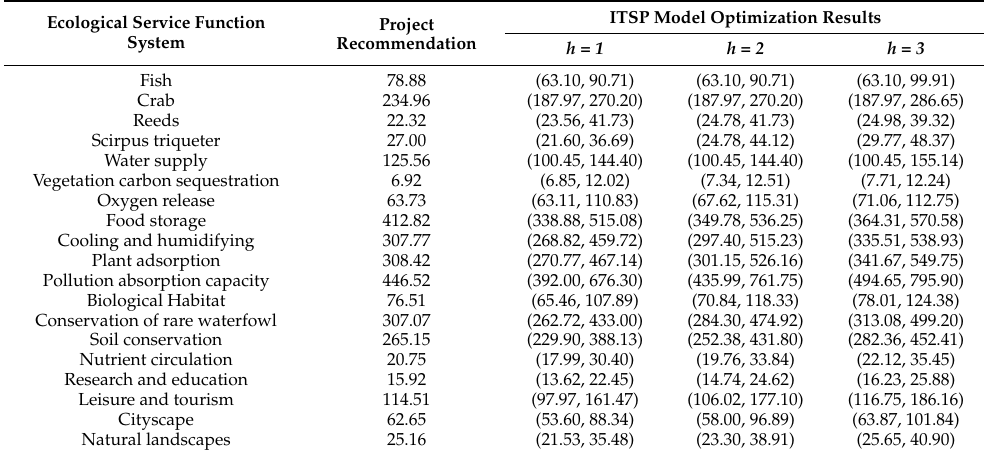
Table 1. Estimated ESV of JMNNR under the ecological service function system ( × 10 6 yuan). Ecological Service Function